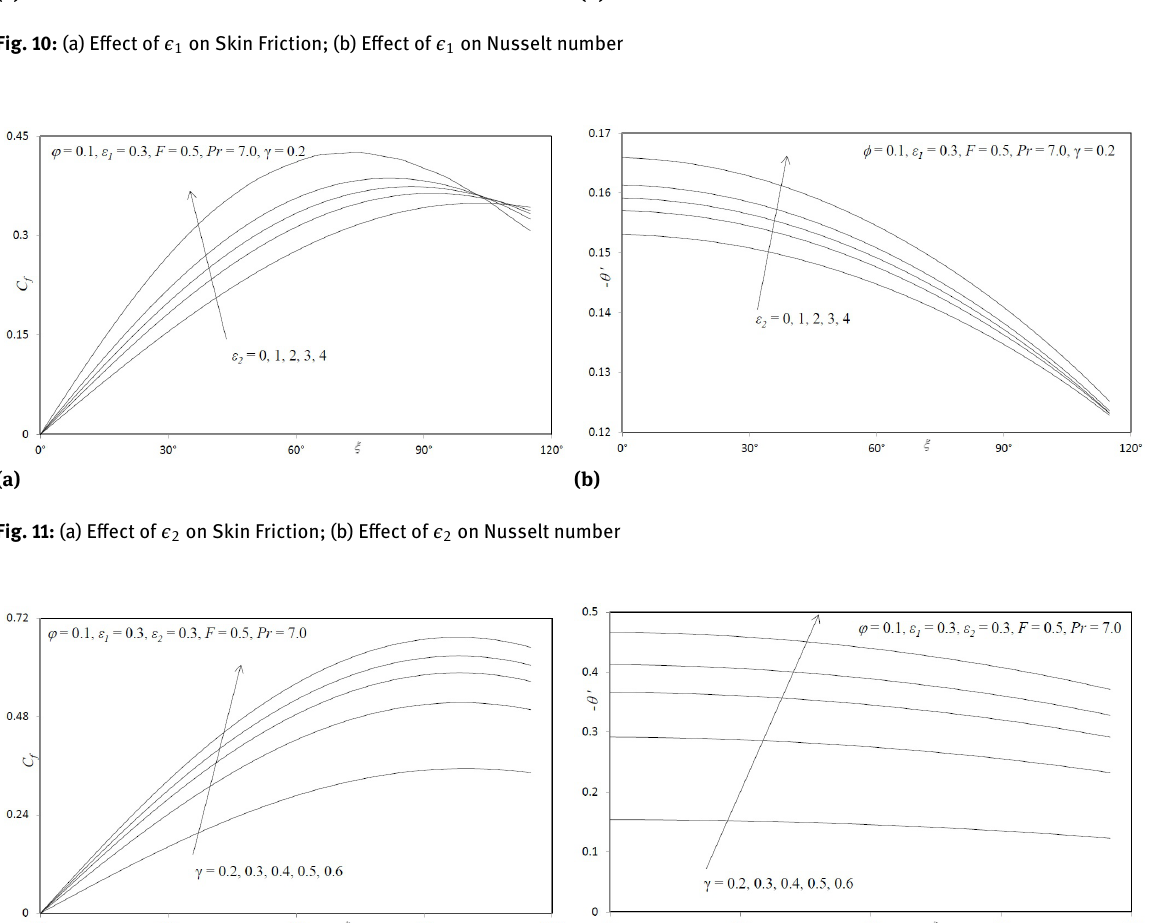
Fig. 12(a)–12(b) presents the influence of the Biot num- ber, γ , on the dimensionless skin friction coefficient, C f and heat transfer rate, − θ (cid:48) ( ξ , 0) at the cylinder surface. The skin friction at the cylinder surface is found to greatly enhance with rising Biot number, γ . This is principally